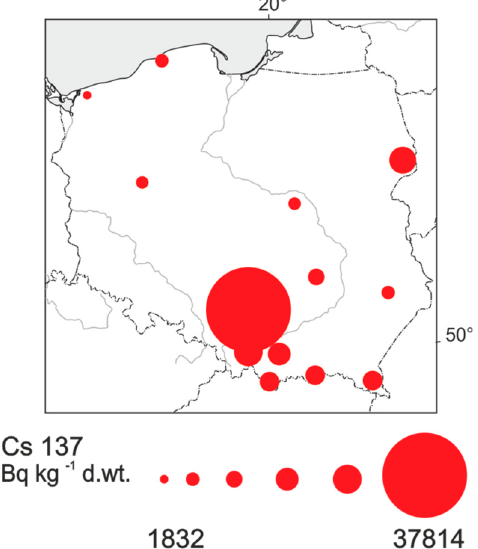
Figure 7. Level of radioactive cesium (Bq kg − 1 d. wt.) in Pleurozium schreberi collected in 1986, in Polish national parks.